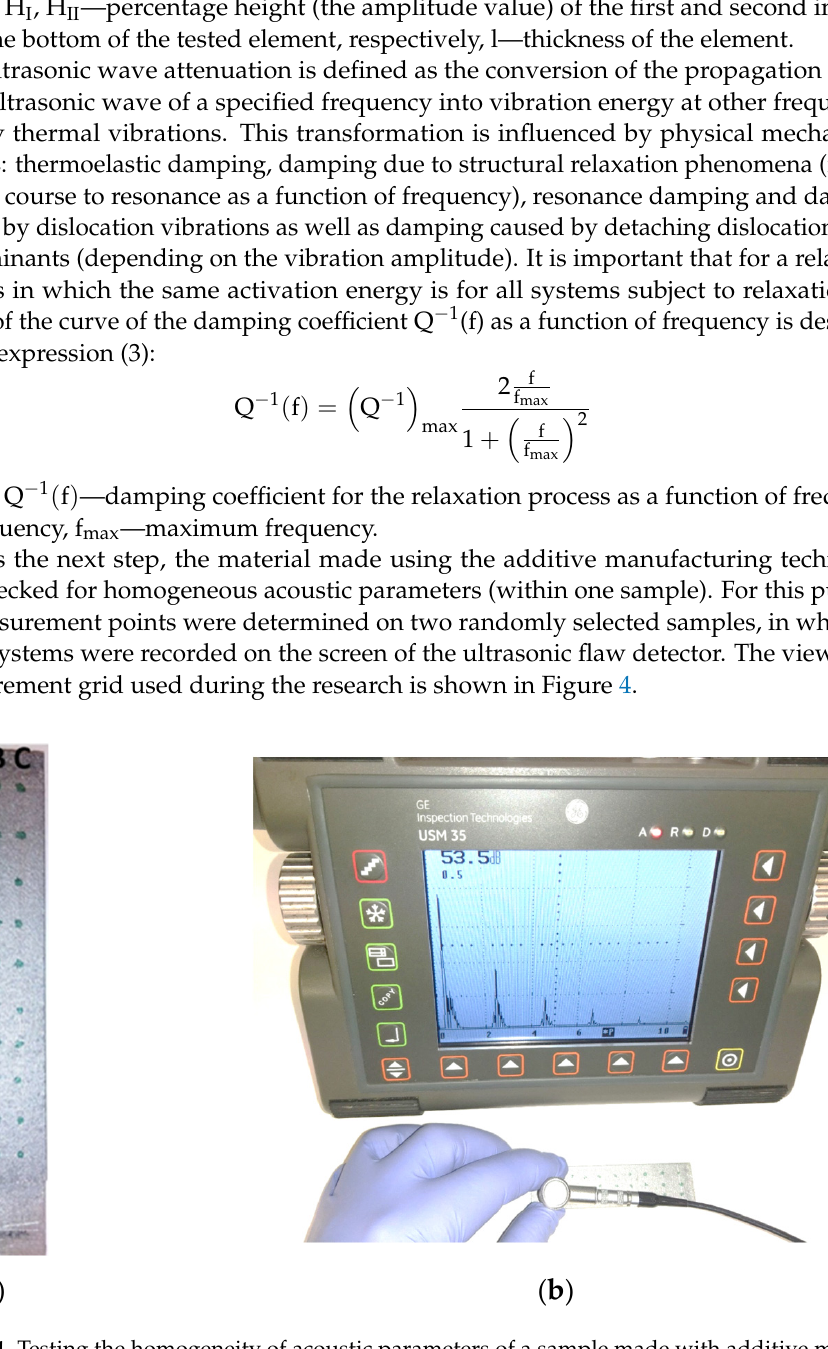
, Figure 5. View of the sample with the measuring grid. 2.3. Mechanical Testing of Joints A Cometech B1/E testing machine (Cometech Testing Machines Co., Taichung Tai- wan) was used in the tests, together with articulated clamps in which the sample was mounted. The jaw speed was 0.05 mm/s and the force was measured with an accuracy of 1 N. Following that, the maximum shear force obtained during the measurements was related to the surface on which the adhesive had been applied. Thanks to this, the shear stress which damaged the adhesive joint was determined. The view of the sample mounted in the jaws of the testing machine is shown in Figure 6.